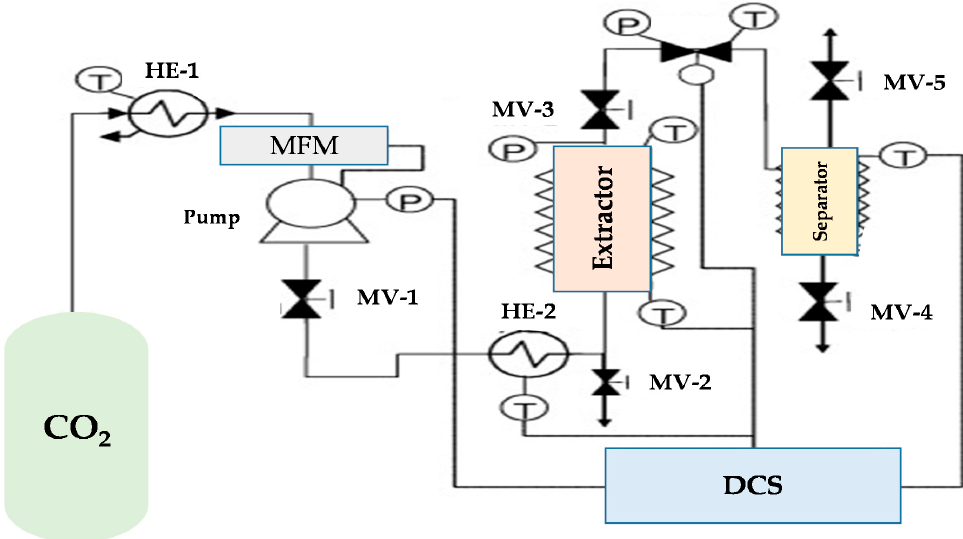
Figure 5. Diagram showing the flow in the extraction process with supercritical carbon dioxide. HE, heat exchanger; MFM: mass flow meter; MV: manual valve; DCS: distributed control system.